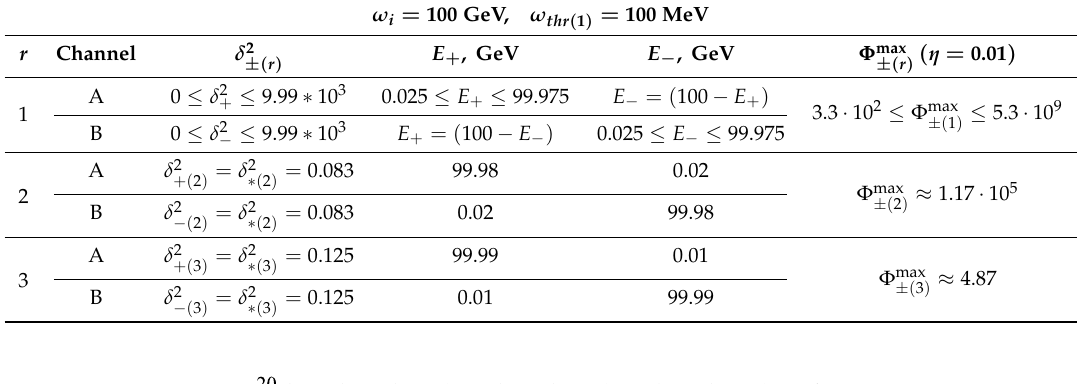
Table 2. The most probable values of the electron-positron pair energies and the corresponding resonant differential cross sections for the the case ε r (cid:29) 1.